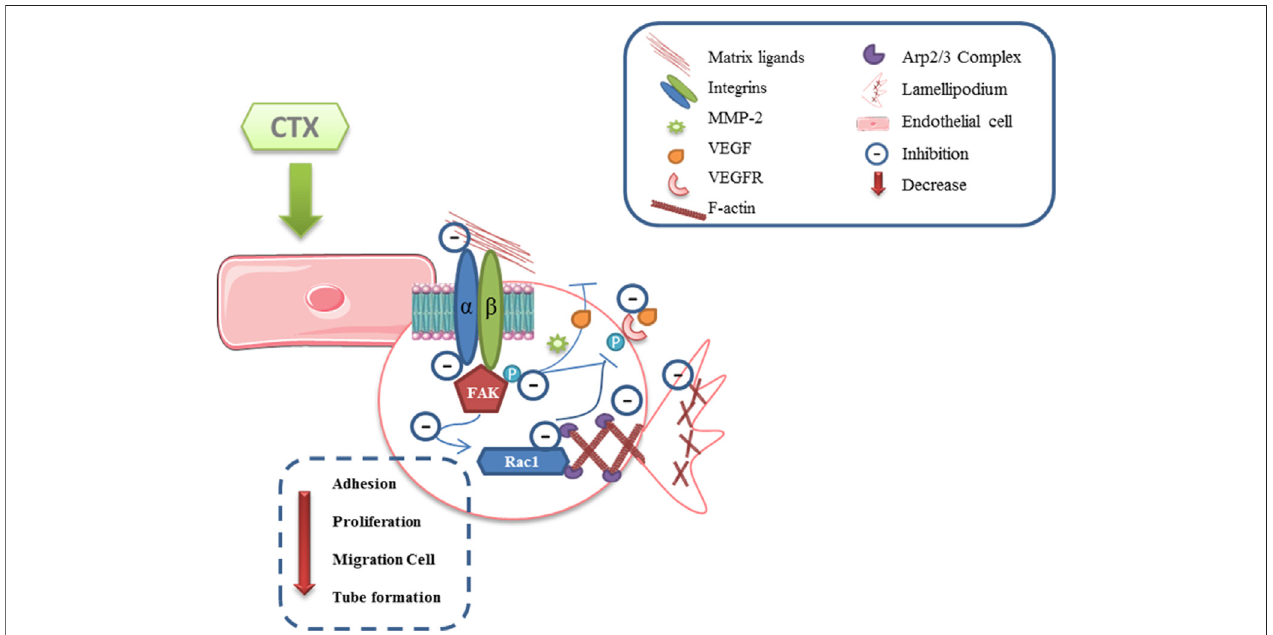
FIGURE 7 | Scheme proposed for anti-angiogenic effect directly induced by CTX. CTX exerts its inhibitory effect by decreasing endothelial cell adhesion to their matrix ligands and, consequently, interferes with FAK kinase phosphorylation, which may lead to the inhibition of Rho GTPases Rac1, since these effector proteins activate theregulation ofcell proliferation, migration, and invasion. Moreover, theinhibitory action on signaling molecules such asFAK may lead to asigni fi cant decrease in the secretion of critical mediators for the development of angiogenesis, MMP-2, while reducing speed and persistence of migration in 3D matrices, and of the VEGF, in turn decrease the stimulus on the same receivers. Furthermore, both of inhibited α v and α 2 subunits of the integrins, and the decrease in VEGF binding to VEGFR lead to the inhibition of the Arp2/3 complex, a key regulator in actin polymerization and stress fi ber formation (Scheme based in Lamalice et al., 2015). Supplementary Material should be uploaded separately on submission, if there are Supplementary Figures, please include the caption in the same fi le as the fi gure. Supplementary Material templates can be found in the Frontiers Word Templates fi le.